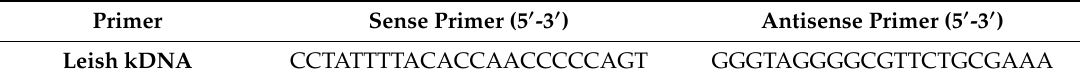
Table 1. Primers used for parasite burden